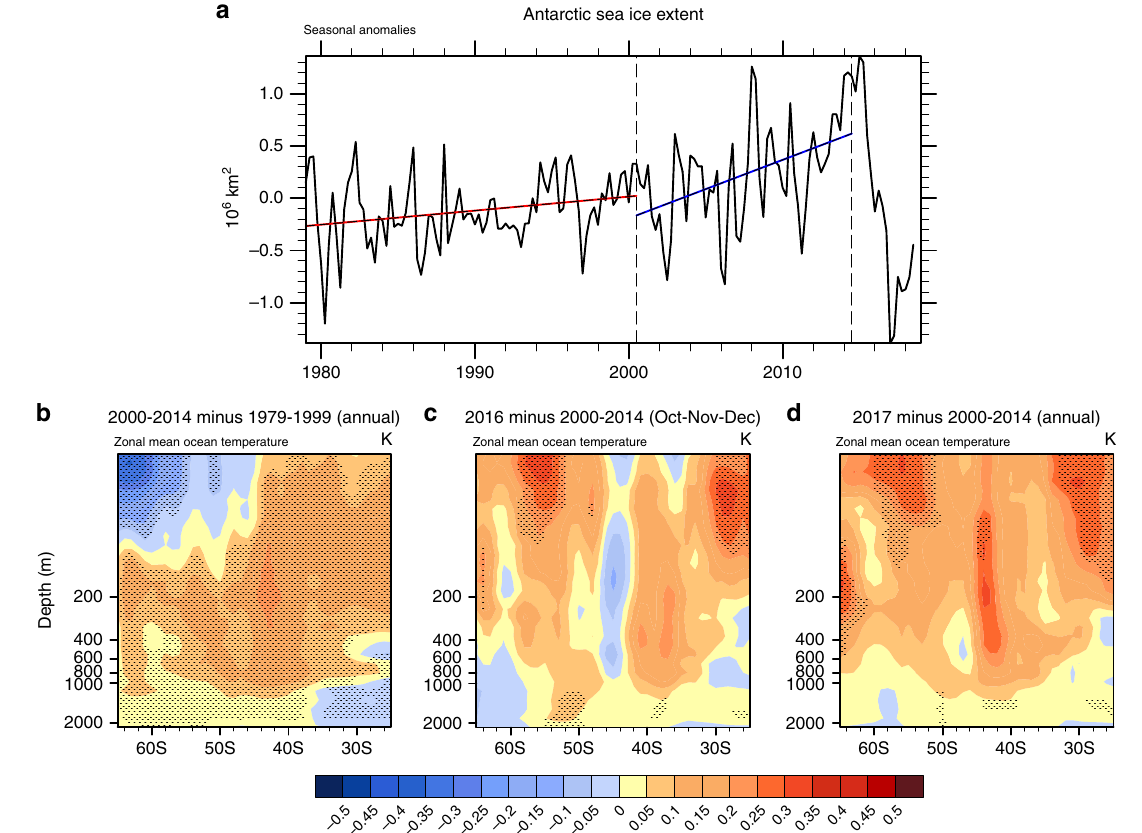
Fig. 1 Antarctic sea ice extent and zonal mean ocean temperatures. a Observed seasonal anomalies of sea ice extent from 1979 through JJA 2018 (10 6 km 2 ), seasonal anomalies from the full available period 1979 – August 2018; vertical dashed lines denote DJF 2000 at the start of the negative IPO period, and DJF 2014 marking the end of the negative IPO period as analyzed in ref. 1 ; trend lines are calculated through the seasonal anomalies. b Zonal mean temperatures (°C) from EN4 reanalysis data, base state differences for the negative IPO period (2000 – 2014) minus positive IPO period (1979 – 1999), stippling denotes signi fi cance at the 5% level; c as in ( b ) except for October – November – December (OND) 2016 minus 2000 – 2014 OND mean; d as in ( b ) except for 2017 annual mean minus 2000 – 2014